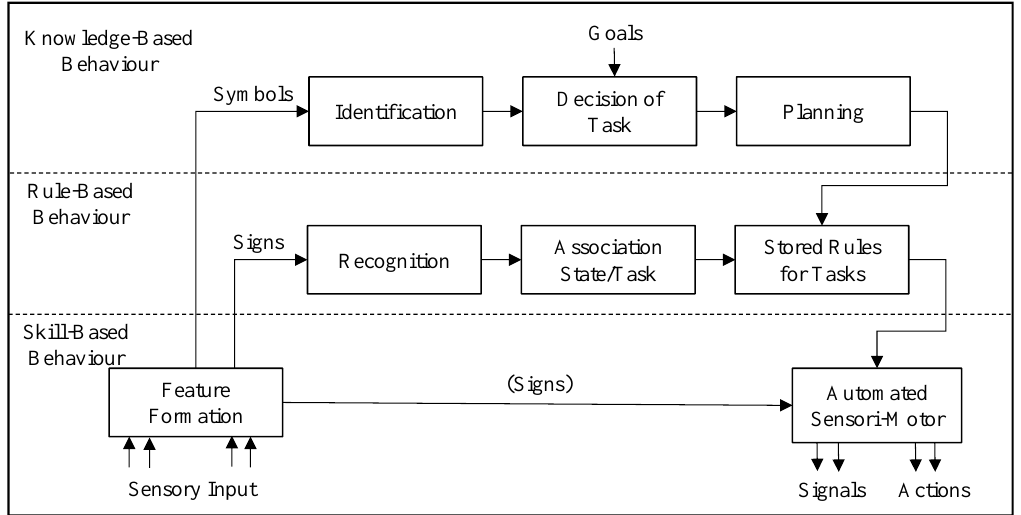
Figure 1. The Skills, rules, knowledge(srk) framework (Rasmessen,